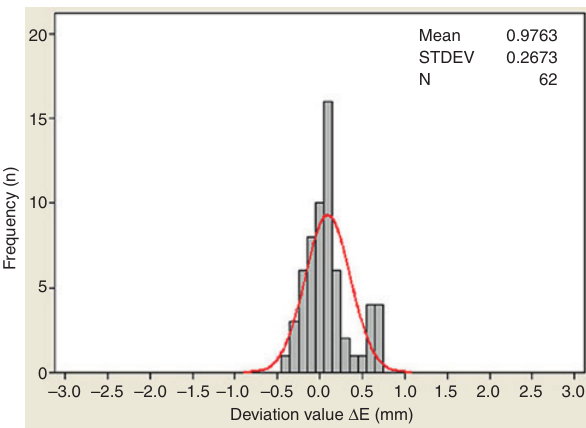
Figure 12: The data points normal distribution under the optimal experiment scheme.